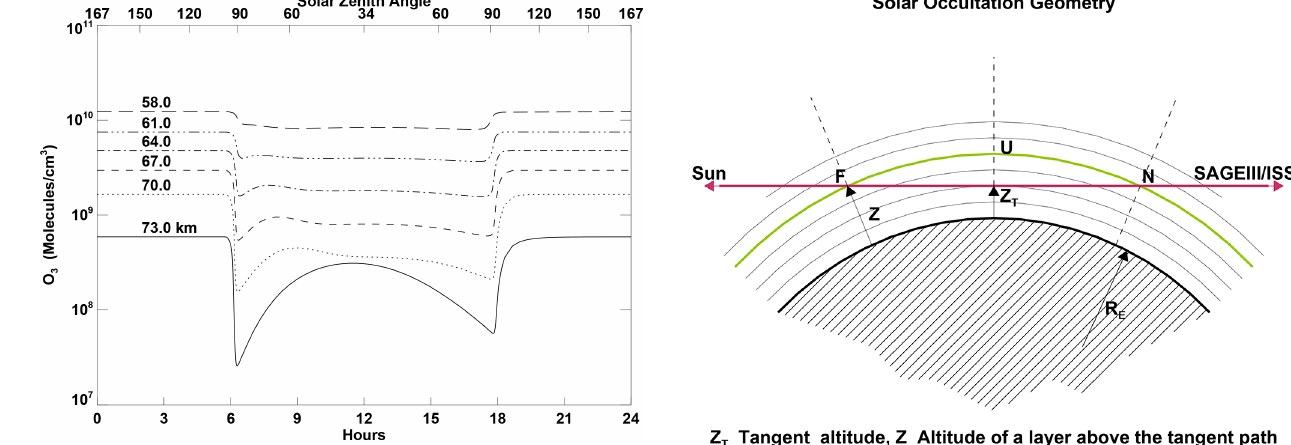
Figure 1. Diurnal variation in O 3 at 11.25 ◦ S in June at altitudes from 58 to 73km. 0h denotes midnight. The upper x-axis shows the variation of SZA.